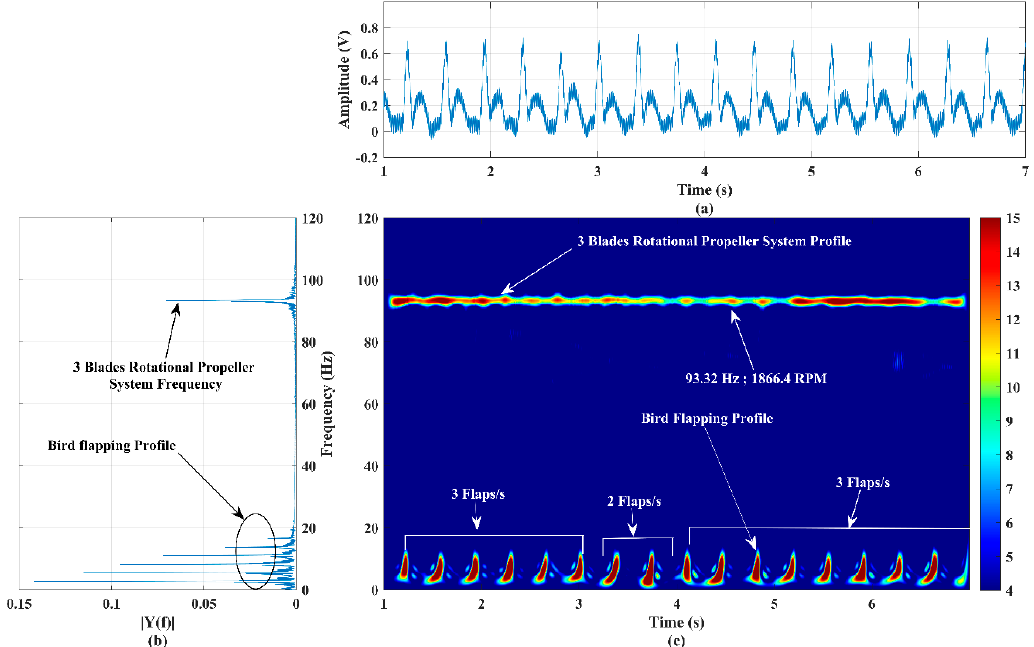
Figure 7. ( a ) Time − series plot, ( b ) power spectrum plot, and ( c ) micro − Doppler signature/pattern image designed using the improved SP − WVD for simultaneous activities of two targets: a three − blade rotational propeller system and a bionic bird’s flapping actions.